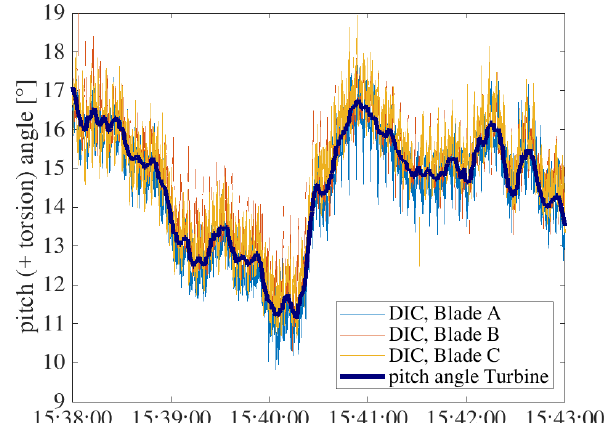
Figure 21. Comparison of OoP deformation of DIC and simula- tions of blade B – mean values with standard deviation.